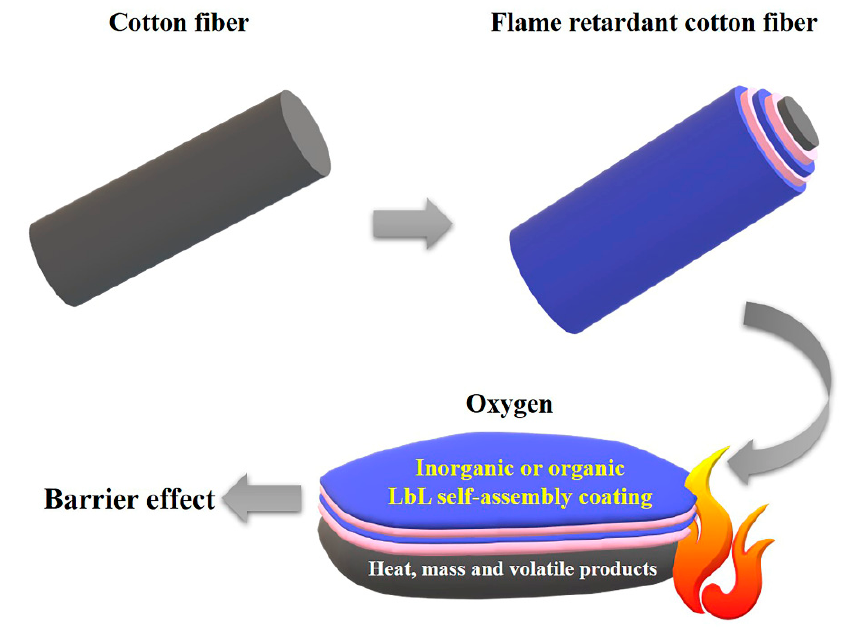
Figure 6. Schematic of flame-retardant mechanism of LbL self-assembly